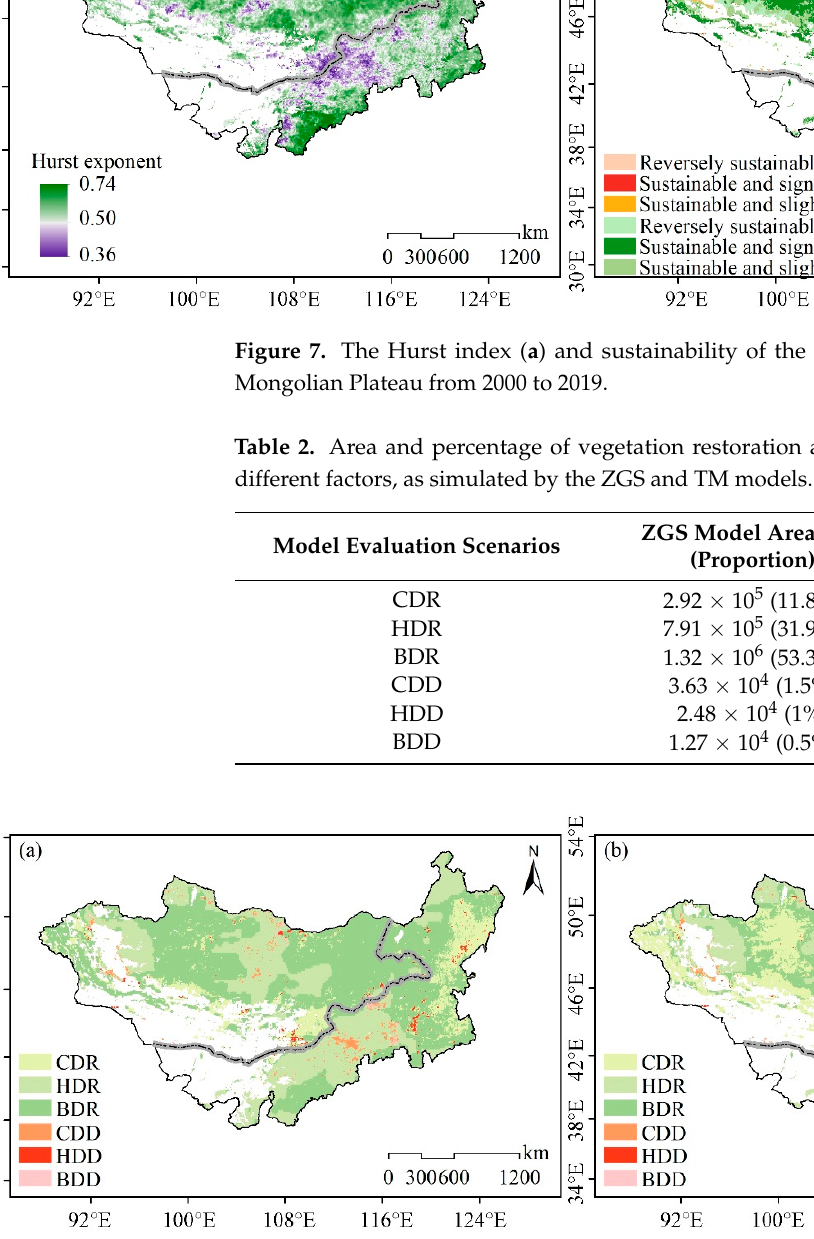
Figure 7. The Hurst index ( a ) and sustainability of the changing trend ( b ) of the ANPP in the Mon- golian Plateau from 2000 to 2019.